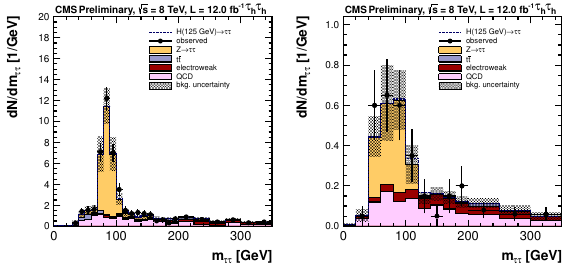
Figure 3. Fully reconstructed invariant mass of the di- τ system in the τ h τ h decay channel. Shown are the invariant mass distribu- tions in the (left) 1-Jet and (right) the 2-Jet (VBF) event category.